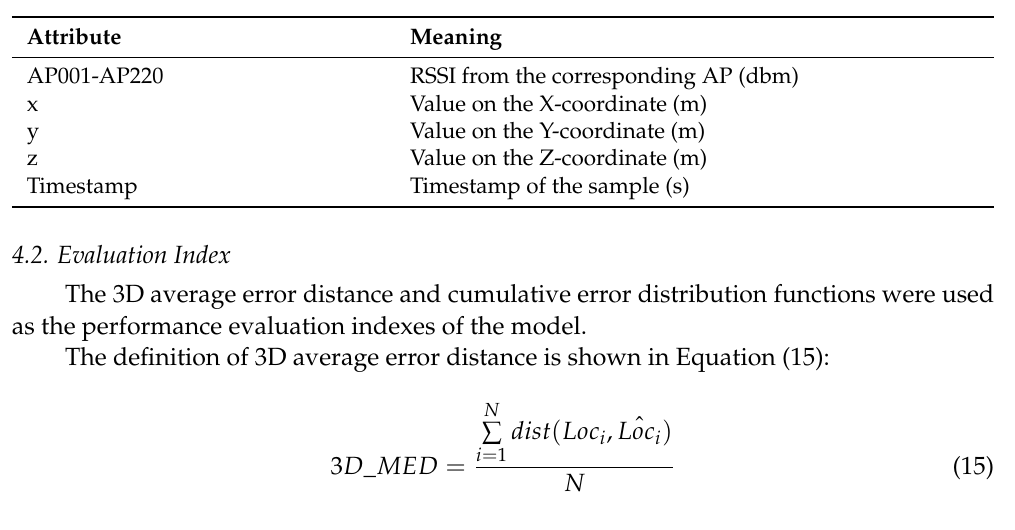
Figure 8. An example of temporal fingerprint collection. Specific attribute information for the dataset is presented in Table 4. A total of 220 APs were placed in the environment and a default value of − 100 dBm was used to repre- sent the undetected APs. Table 4. IMUWIFINE dataset